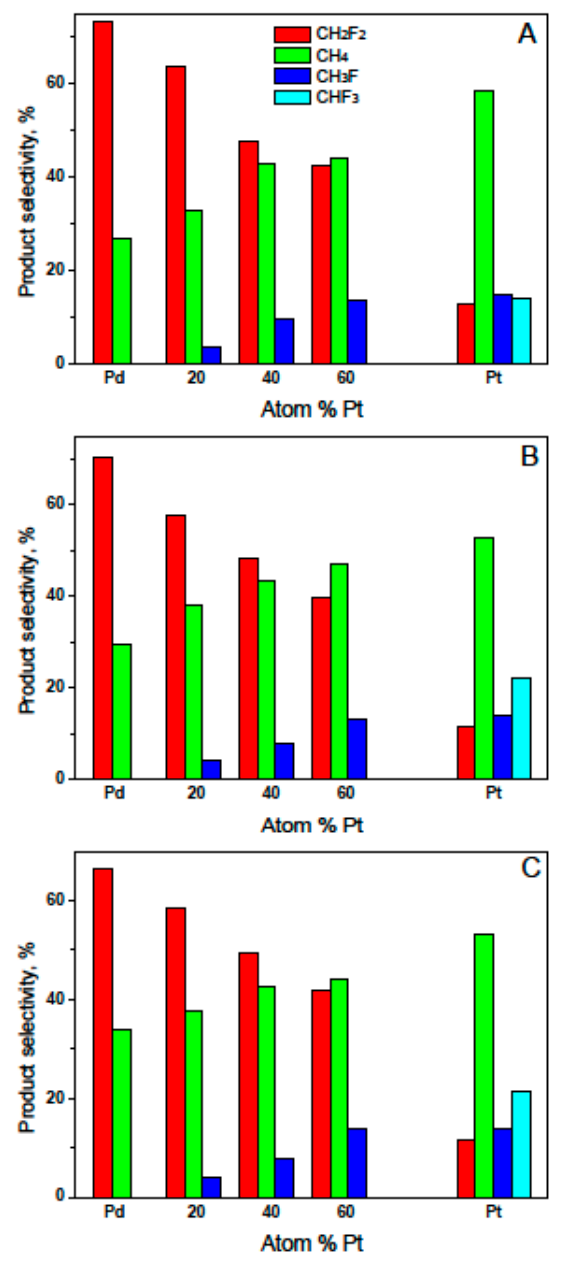
Figure 1. CHClF 2 hydrodechlorination over 2 wt % Pd–Pt(acac)/Norit1600 catalysts at 272 °C. The effect of nominal bimetal composition on product selectivity. ( A )—after precalcination at 320 °C (1 h), ( B )—after precalcination at 350 °C (1 h), and ( C )—after precalcination at 400 °C (0.25 h).